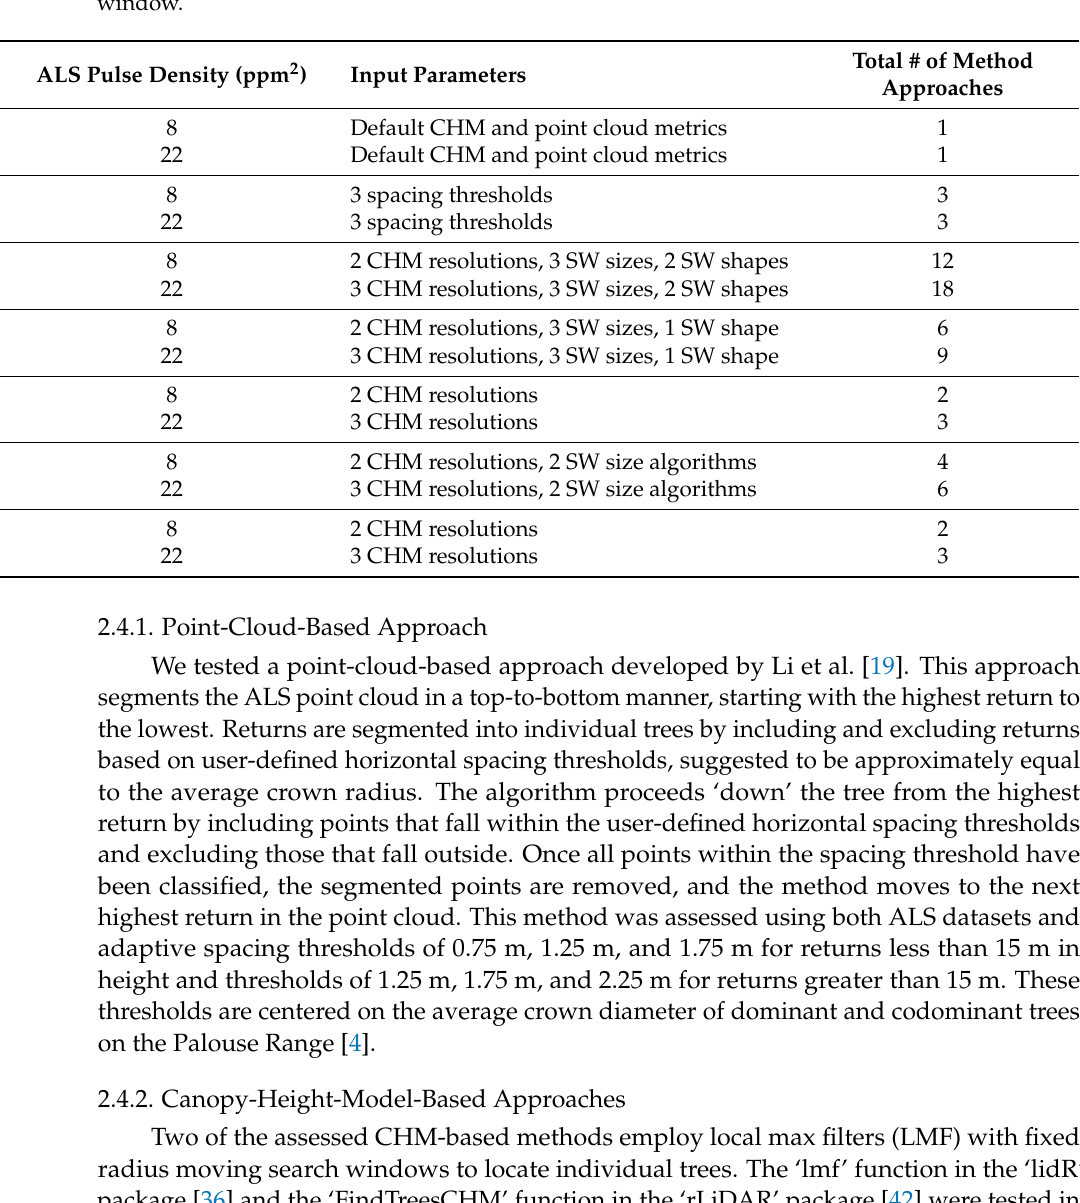
Table 2. ITD method approaches tested in this study. CHM: canopy height model; SW: search